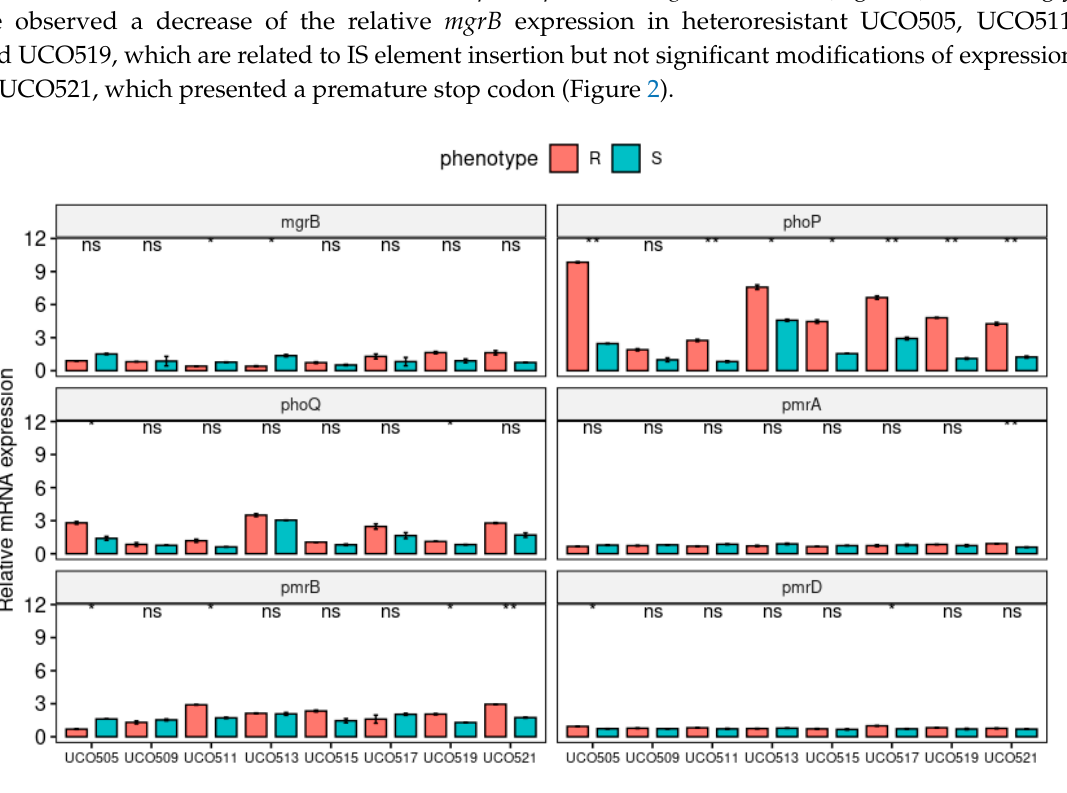
Figure 2. Relative expression (RT-qPCR) of the CST-resistance genes mgrB , phoPQ , and pmrABD in CST-susceptible (S) and CST-HR-derived (R) K. pneumoniae strains. * p < 0.05; ** p < 0.01, ns: not significant.